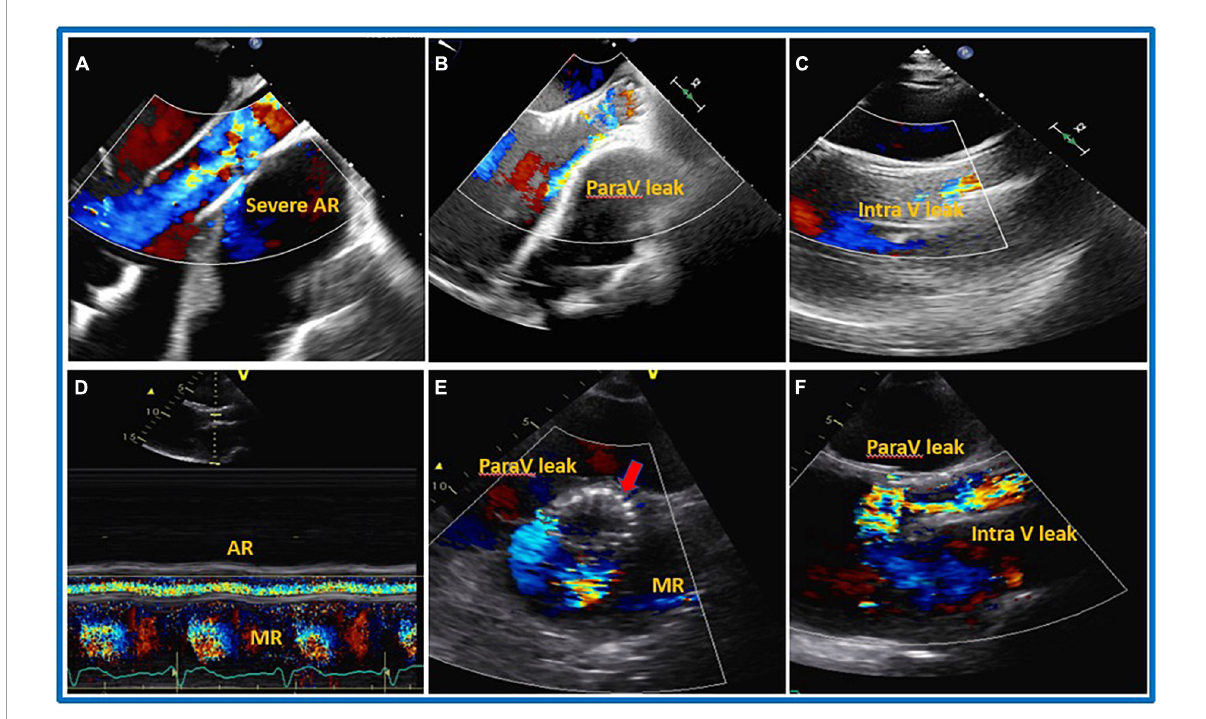
FIGURE6 Transcatheter aortic valve implantation (TAVI) procedure. 32 years old gentleman with severe dilated cardiomyopathy, severe reduced systolic function (Ejection Fraction less than 10%), severe dilated and reduce systolic function of the right ventricle (RV), on left ventricular assist device (LVAD) as Bridge To Therapy (BTT) developed severe aortic regurgitation (AR). On transthoracic (TTE) the patients also had severely dilated RV, severe tricuspid regurgitation (TR) and associated severe liver and kidney dysfunction on hemodialysis. The patient underwent TAVI procedure with mild to moderate residual intravalvular AR. Five days after the procedure, TTE was repeated showing the presence of severe PV leak and the possible protrusion of the prosthesis into left ventricular outflow tract (LVOT). The patient died after 10 days from the procedure due to end stage heart failure and multi organ failure. (A) Pre-TAVI implantation, (B) TTE, mild to moderate paravalvular leak during TAVI procedure and before aortic valve (AV) deployment, (C) parasternal long axis TTE just after deployment, mild to moderate intra and paravalvular leak, (D–F) 5 days later S/P TAVR with likely severe intra and paravalvular leak, possible protrusion of the AV prosthesis into LV. (D) Color M-mode with AR in systole and diastole. (E) Shot axis. (F) Parasternal long